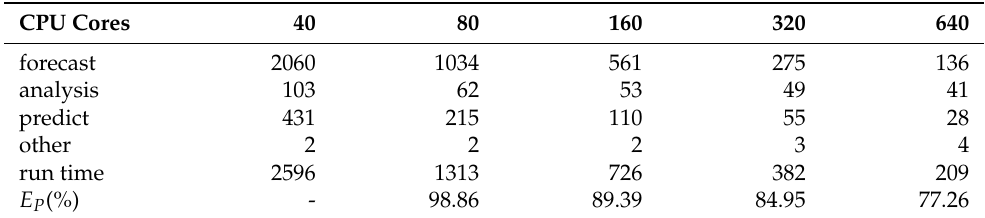
Table 7. The computational time and parallel efficiencies for the unknown endpoint example (time unit: second).